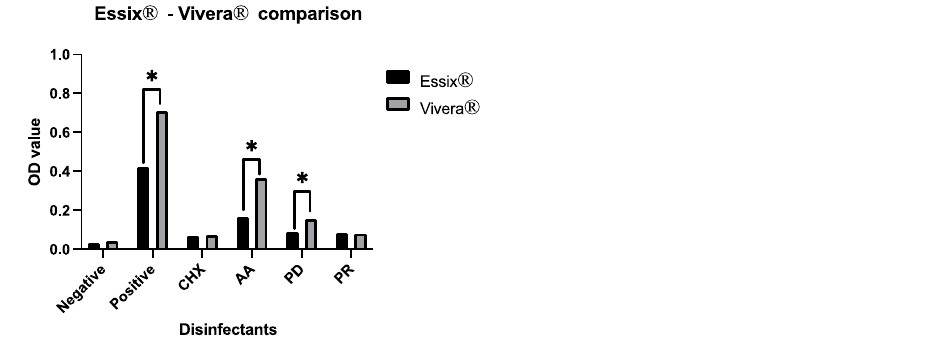
Figure 1. The comparison between two types of thermoplastic retainer after cleaning with each agent, * ( p < 0.05). Polymers 2022 , 14 , x FOR PEER REVIEW